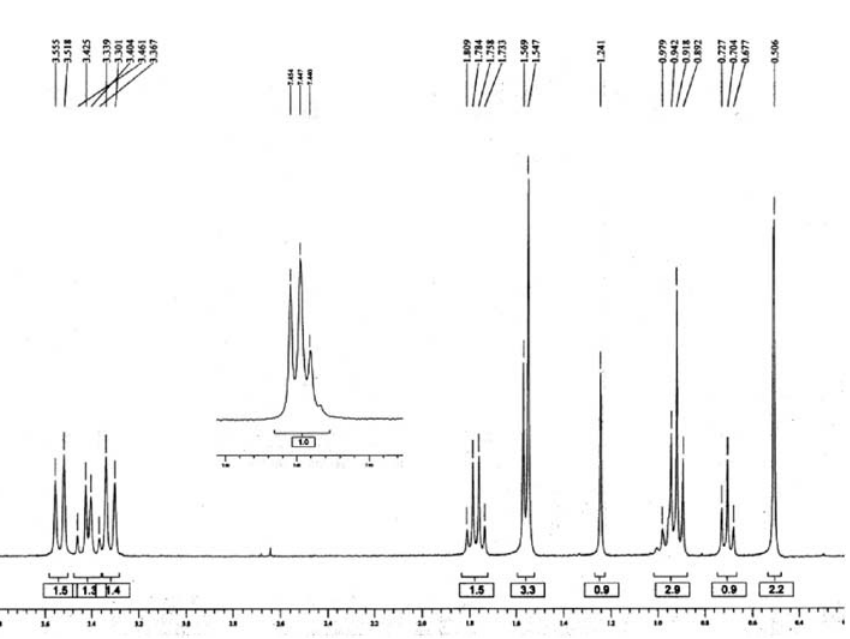
Fig. 3 1 H-NMR spectrum (300 MHz, CDCl 3 ) of the cis-trans-trans isomer of 5 . measured for the deshielding of the protons of ethyl groups are higher for the methylene protons [ δ (A) = 1.77 ppm; δ (B) = 0.93 ppm; Δ δ = 0.84 ppm] than for the methyl groups [ δ (A) = 0.91 ppm; δ (B) = 0.70 ppm; Δ δ = 0.21